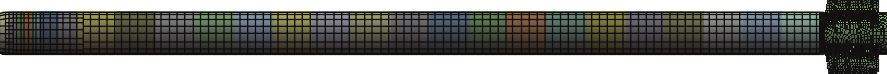
Figure 4: Solid region grid.